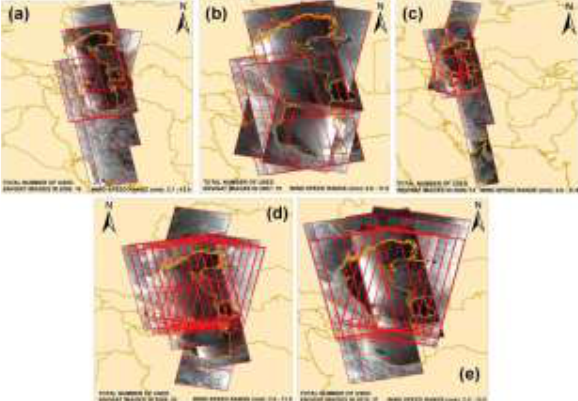
Figure 5. Extents of ENVISAT ASAR Wide Swath Medium Resolution images suitable for oil spill detection in (a) 2006; (b) 2007; (c) 2008; (d) 2009 and (e) 2010